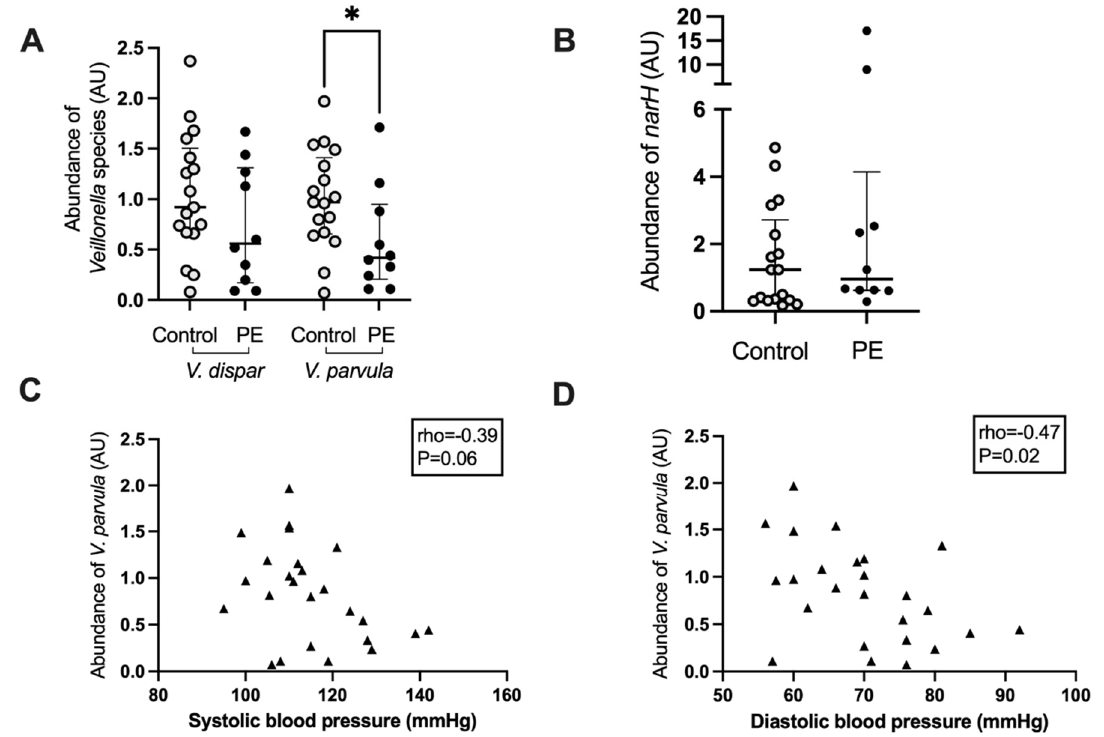
Figure 4. Veillonella species abundance ( A ) and nitrate reductase subunit narH ( B ) in the maternal oral microbiota of women who developed preeclampsia and controls. Correlation of maternal systolic ( C ) and diastolic ( D ) blood pressure with the abundance of narH in the oral microbiota. Light grey circles, samples from control women; black circles, samples from women who develop preeclampsia, black triangles, samples from all women; *, p < 0.05.